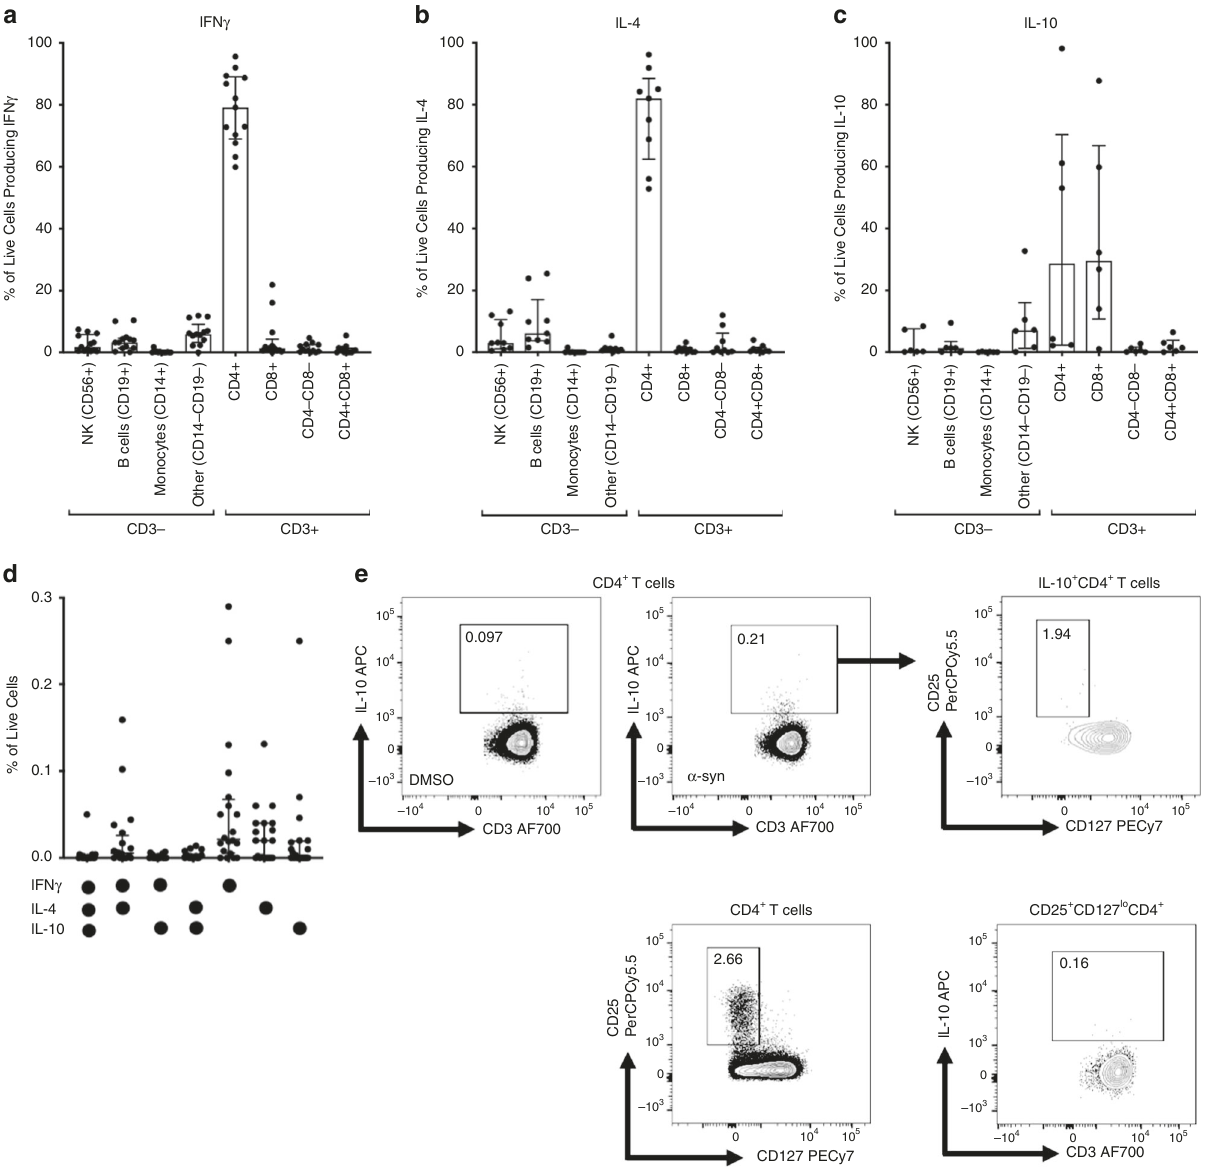
Fig. 5 IFN γ , IL-4, and IL-10 are produced by distinct T cells in response to α -syn. a – d After eliminating non-lymphocytes/monocytes and doublet cells by forward and side-scatter and dead cells by Live/Dead stain, cells were gated based on their cytokine expression and then cytokine-expressing cells were gated based on their CD3 + and CD56 + expression. CD3 + T cells were gated based on their CD4 and CD8 expression (CD8 + , CD8 + CD4 + , CD4 + , CD8 − CD4 − ), and other populations based on CD3 − CD56 − and other markers as indicated; CD14 − CD19 + (B cells), CD14 + CD19 − (Monocytes), CD14 − CD19 − (other) (Supplementary Fig. 5), and percentage live cells expressing cytokine from each of these were plotted. Samples with a frequency of cytokines below 0.02% of live lymphocytes after removal of background were excluded from this analysis. a IFN γ ( n = 13), b IL-4 ( n = 9), and c IL-10 ( n = 6). Median ± interquartile range is indicated. d Boolean gating for combinations of cytokines shown as percentage of live cells, n = 20. Median± interquartile range is indicated. The gating strategy is shown in Supplementary Fig. 5. e Plots were gated on IL-10 + CD4 + T cells following negative control (DMSO) or α -syn stimulation. The gating strategy leading up to this step is shown in Supplementary Fig. 5. IL-10 + cells were then gated further on CD25 and CD127 expression (top row). Plots were gated on CD25 + CD127 lo CD4 + T cells and then on IL-10 production (bottom